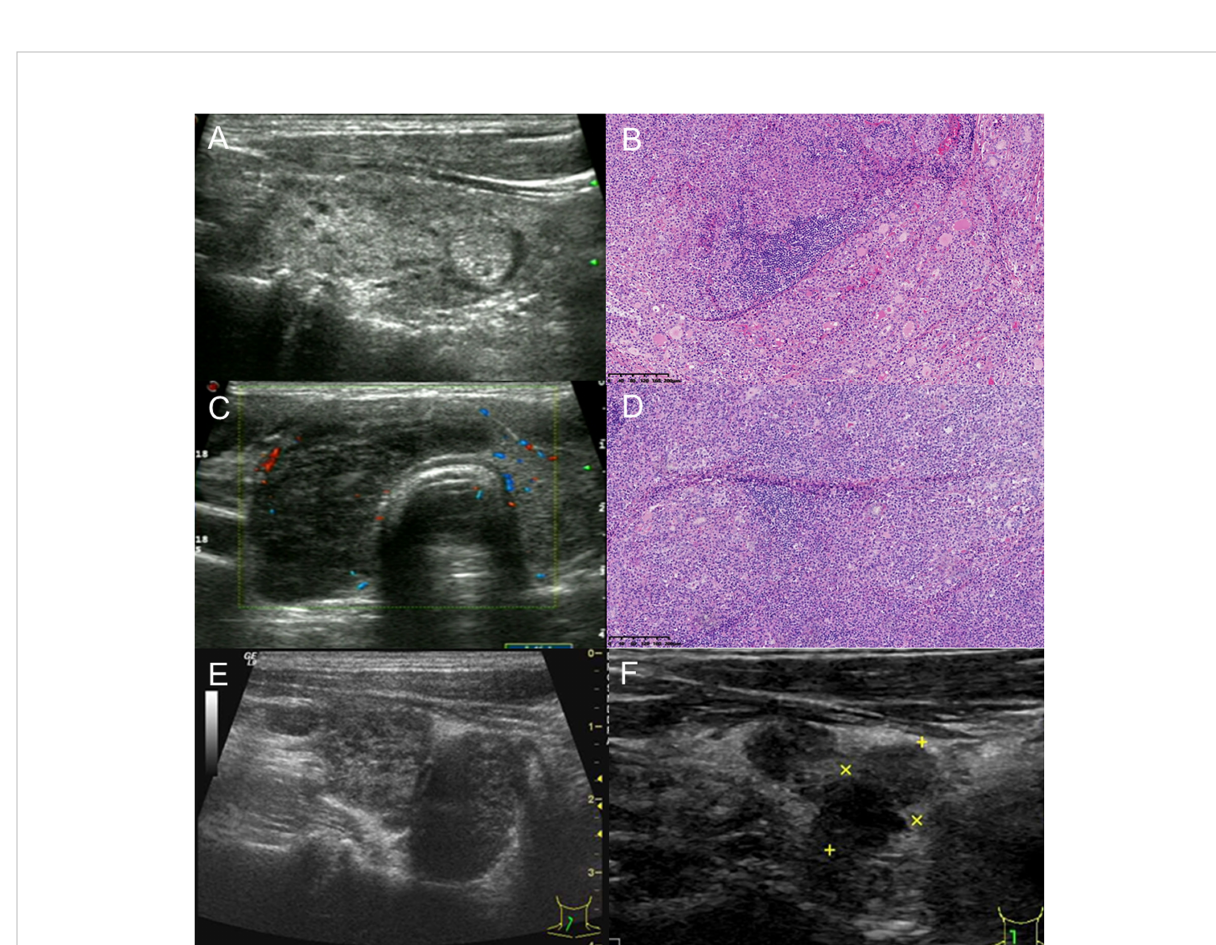
FIGURE 1 A 61-year-old man with thyroid MALT lymphoma underwent subtotal thyroidectomy. (A) Left thyroid with MALT lymphoma and concomitant Hashimoto thyroiditis: a rare ultrasonic manifestation of diffuse micronodules. (B) The left thyroid parenchyma was effaced by a sheet-like and nodular in fi ltrate of small- to medium-sized lymphoid cells with centrocyte-like, monocytoid, and plasmacytoid appearance. Lymphoepithelial lesions and some residual follicles were noted (H&E, ×100). (C) The markedly enlarged right thyroid with very hypoechoic misdiagnosed